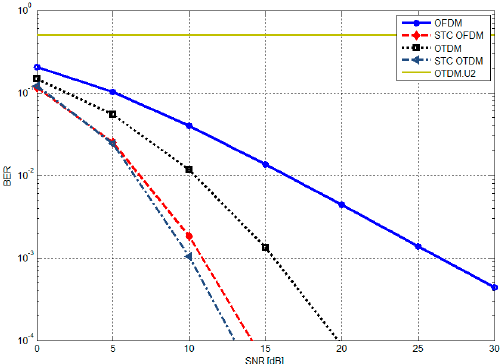
Figure 3. Bit error rate (BER) of the proposed technique (STC OTDM) in comparison with other = 16 and L = 9 using multicarrier techniques at N = 16 and L = 9 using QPSK. multicarrier techniques at N